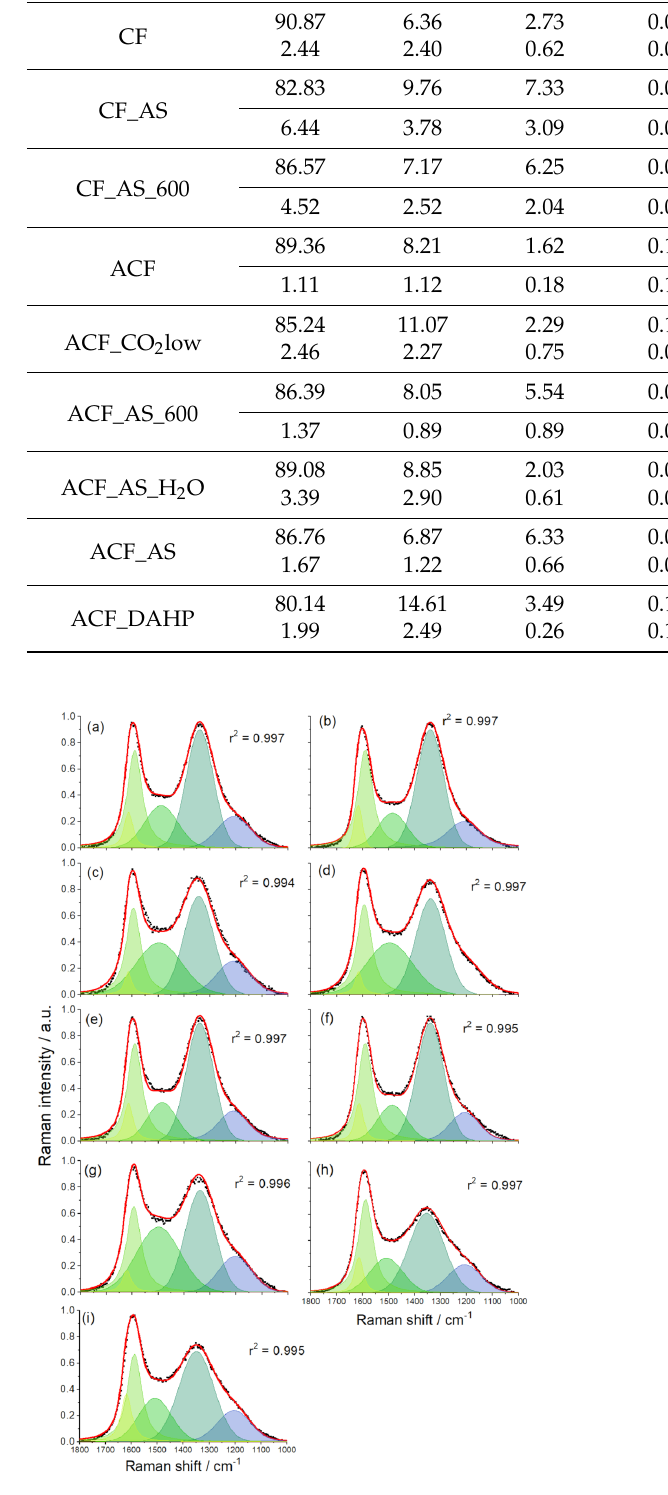
Figure 2. De-convoluted Raman spectra of the studied samples: ( a ) ACF, ( b ) ACF_DAHP, ( c )